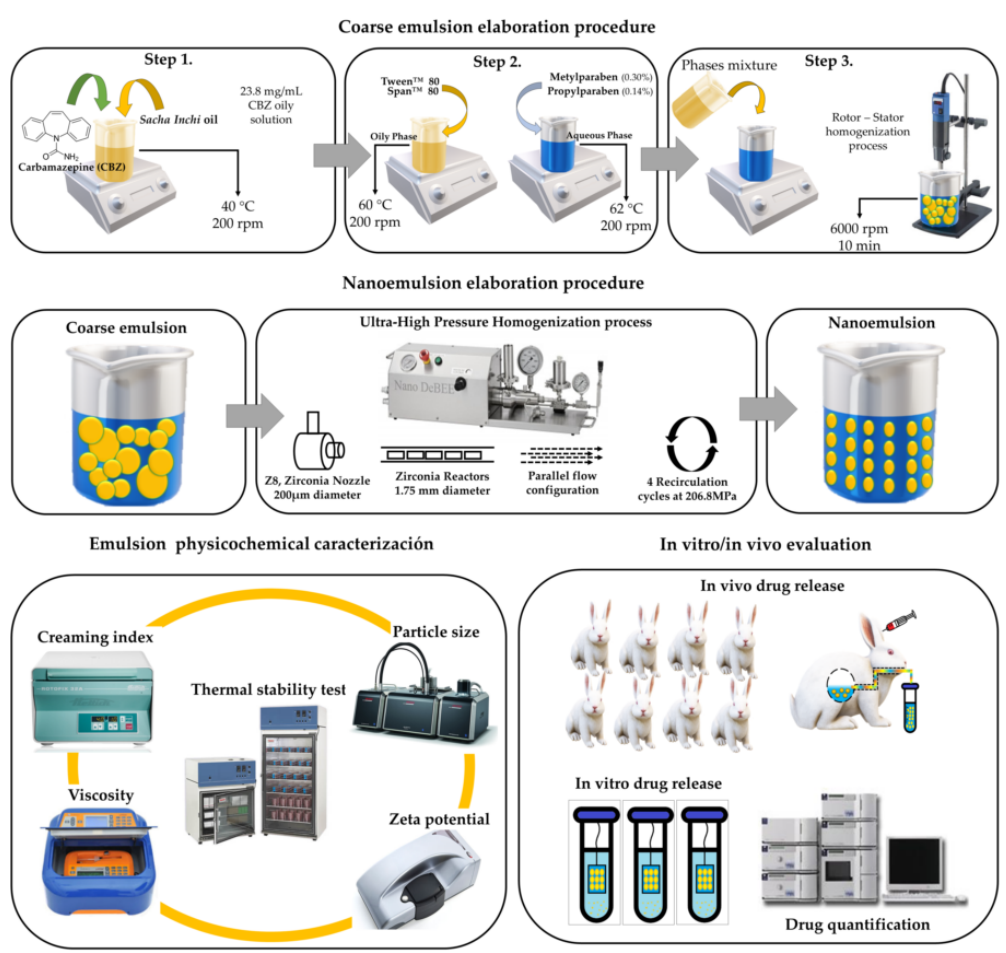
Figure 1. Schematic of the elaboration process, physicochemical characterization, and drug release assays for emulsified carbamazepine (CBZ) formulations.